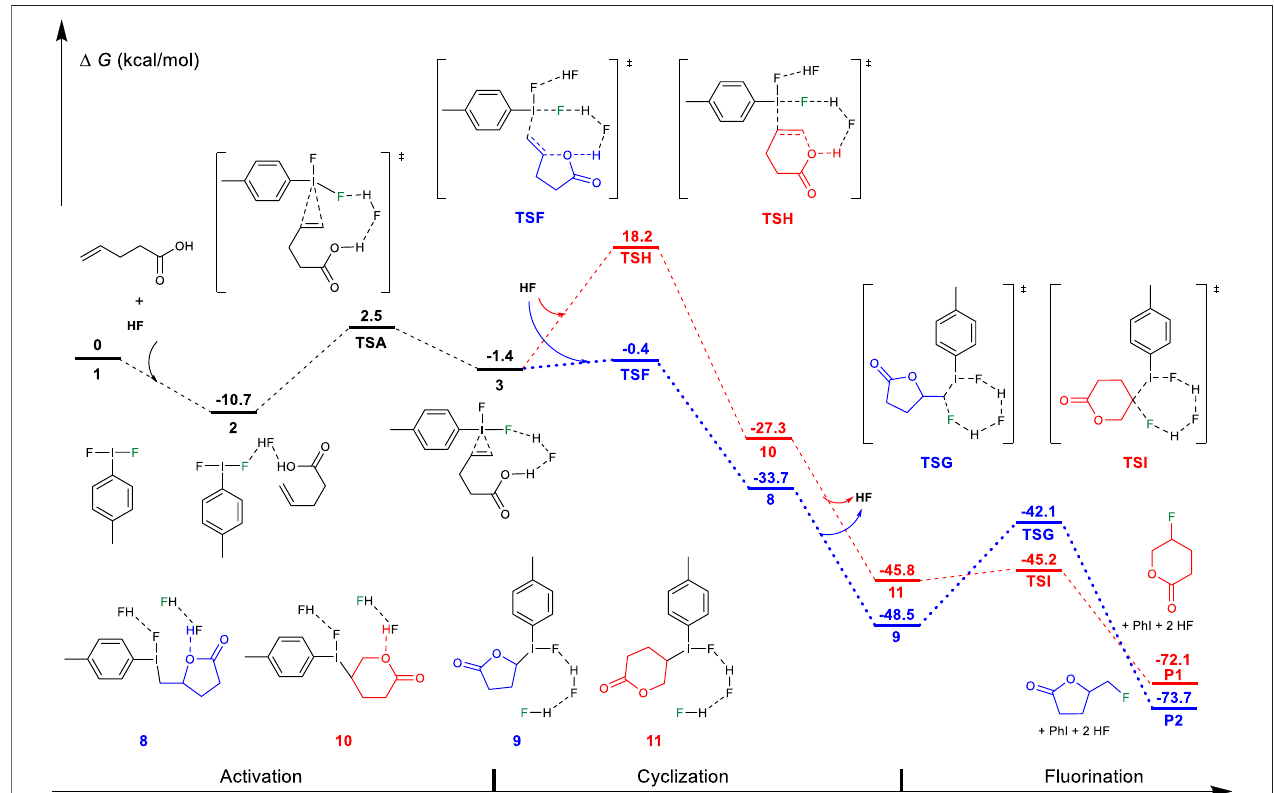
FIGURE 3 | Free-energy pro fi les for the fl uorocyclization of unsaturated carboxylic acid via the “ cyclization fi rst and fl uorination later ” mechanism. The preferred pathway is shown in blue.